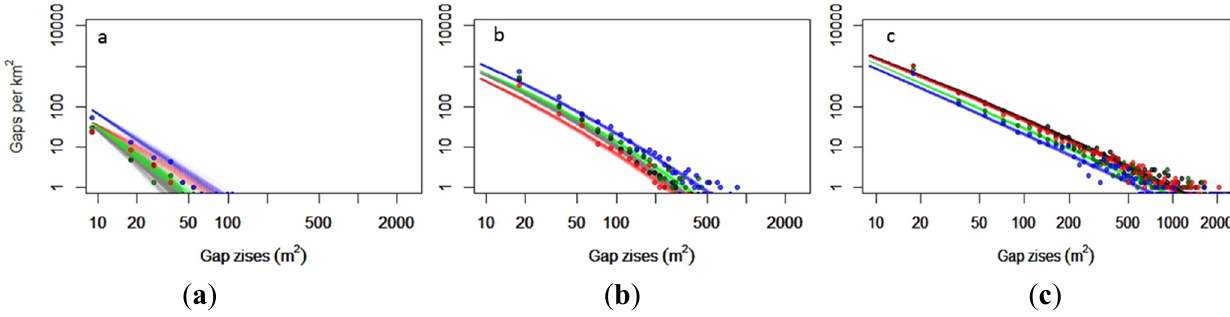
Figure 5. Predicted (lines) and observed (points) frequencies of canopy gap sizes per km 2 , in the four blocks in Gola, at 2 m ( a ), 10 m ( b ) and 22 m ( c ) canopy height tiers. Grey represents block 1; green is block 2; red is block 3; and blue is block 4. Lines are based on the modified power-law distribution function with quadratic term. Lines represent predictions using 100 values selected randomly from the posterior distribution of model